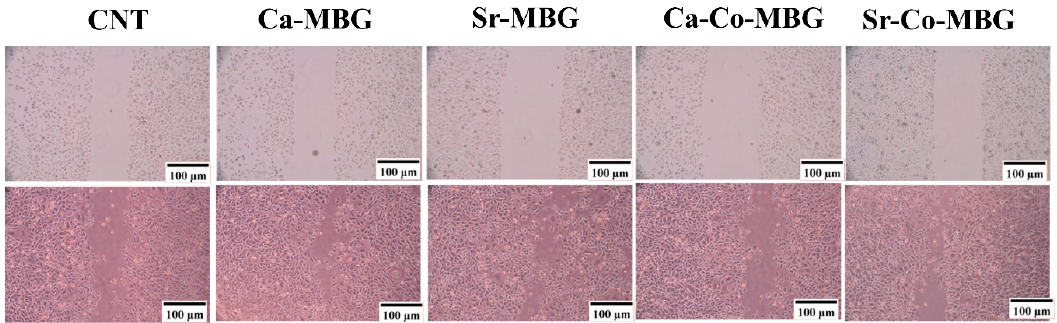
Figure 11. Results of the alizarin red staining assay. High-contrast microscope images ( A ), and quantification results ( B ).